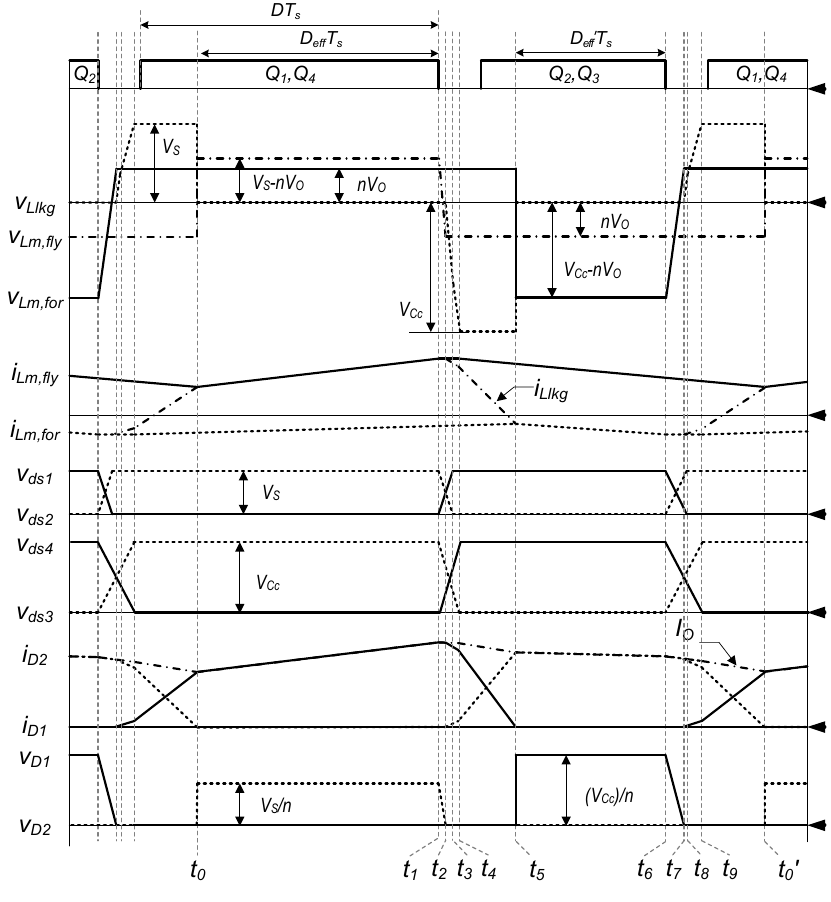
Figure 5. Key operational waveforms of the proposed converter.